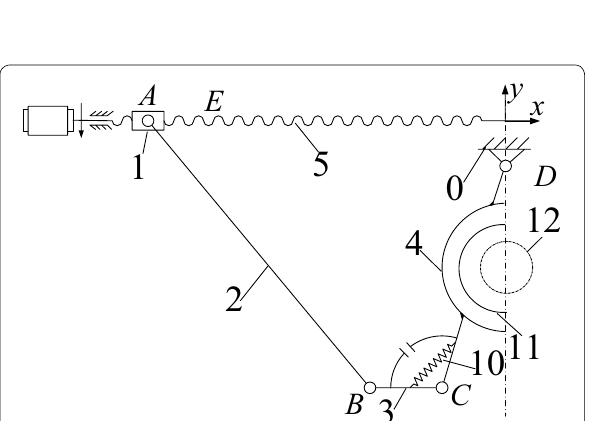
Figure 18 Configuration of changing work stage (configuration II)